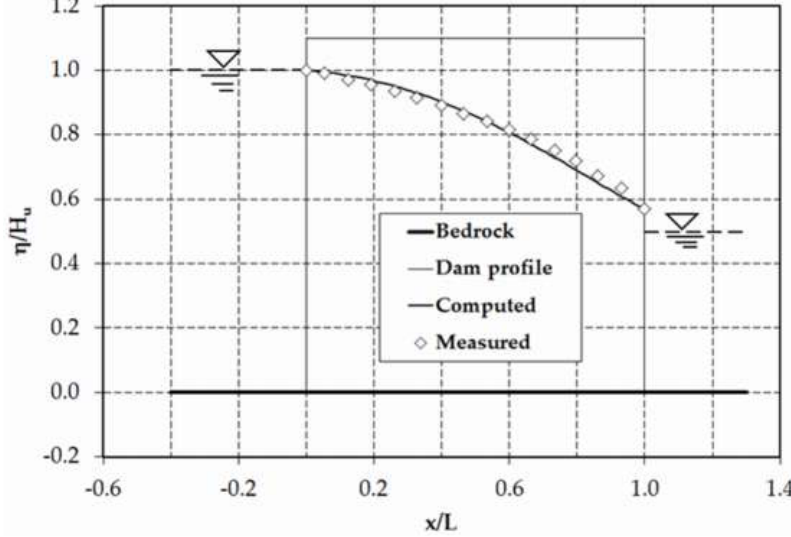
Figure 3. Unconfined seepage flow through a homogeneous rectangular cross-section dam.